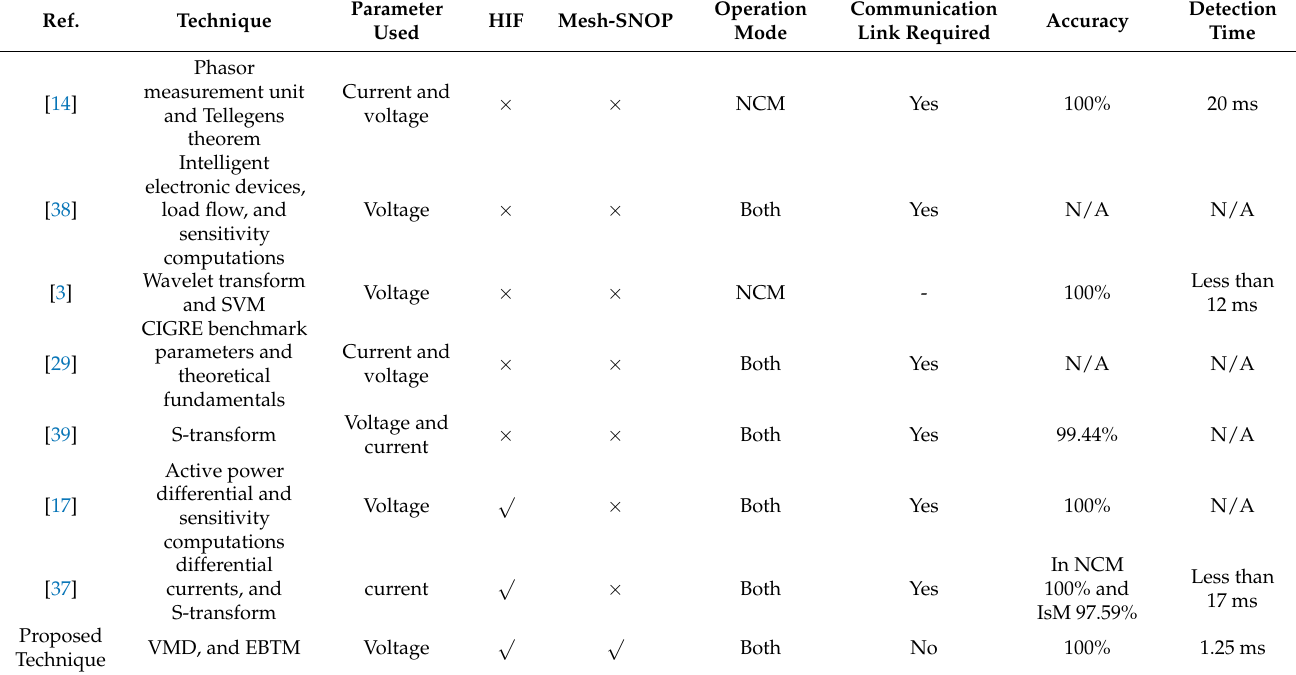
Figure 10. The output fault signal and detection time using the proposed strategy during single line to ground fault. Table 4. Comparison of the proposed technique with several existing strategies. Ref.